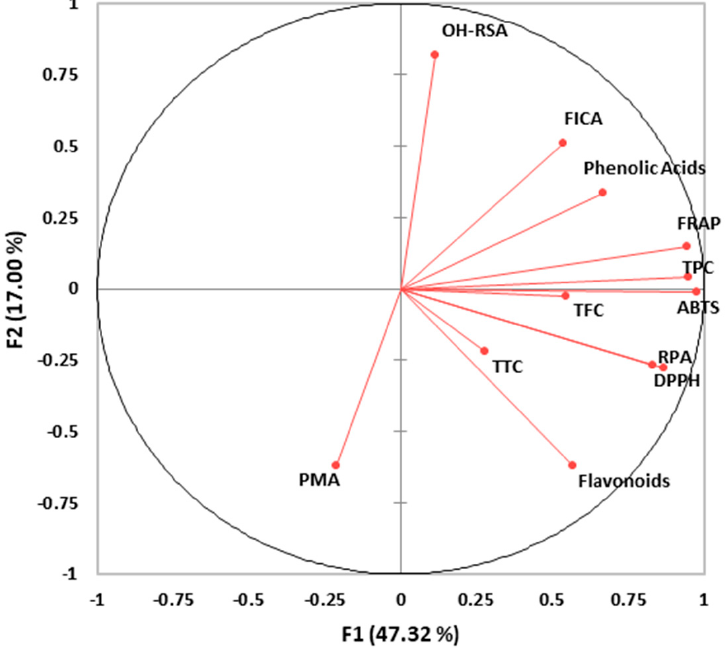
Figure 2. Principal Component Analysis (PCA) of the phenolic contents (TPC, TFC, TTC, phenolic acids, and flavonoids) and their antioxidant capacities (DPPH, FRAP, ABTS, RPA, • OH-RSA, FICA, and PMA) of twelve spices.